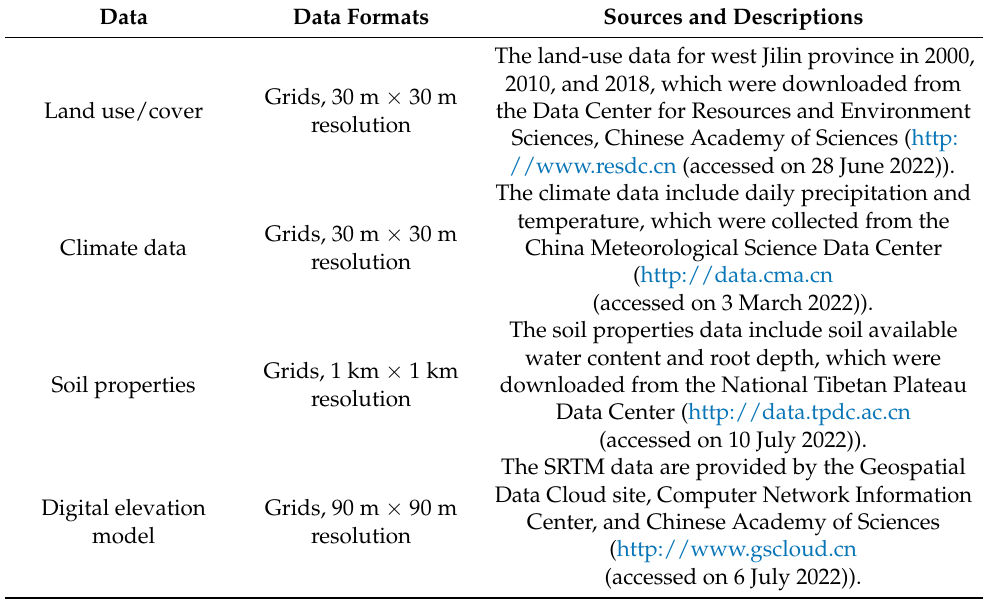
Table 1. The input data sources for water yield